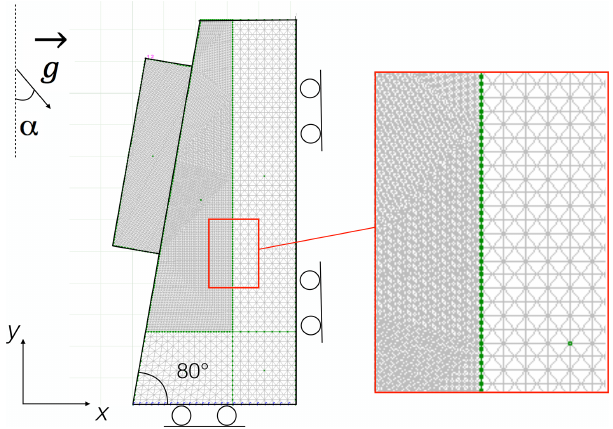
Figure 2. Geometry of both models. α is equal to 0 ◦ for model 1 (slope angle 80 ◦ ) and is equal to 40 ◦ for model 2 (slope angle 40 ◦ ).